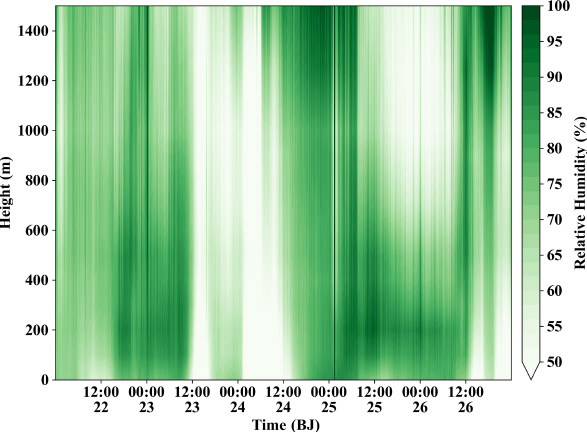
Figure 14. Aerosol backscattering intensity (Mm − 1 sr − 1 ) from 22 to 26 December 2015 in the Beijing area (39.974 ◦ N, 116.372 ◦ E) (the y axis is the height in meters and the x axis is in Beijing time).